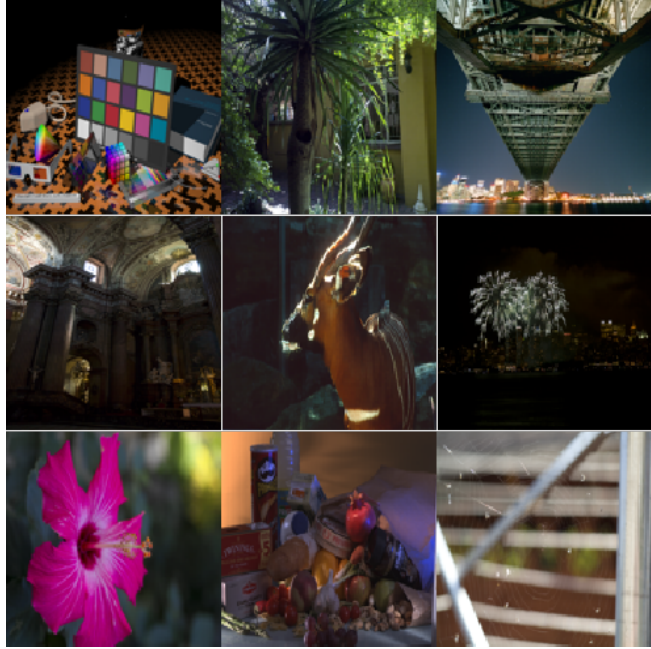
Figure 17. Examples of 8-bit RGB